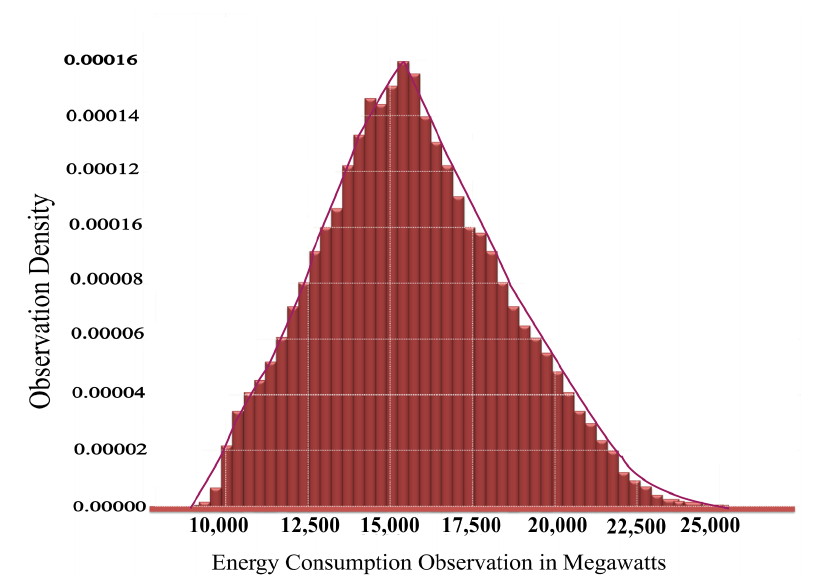
Figure 3. Distribution of the observations in the